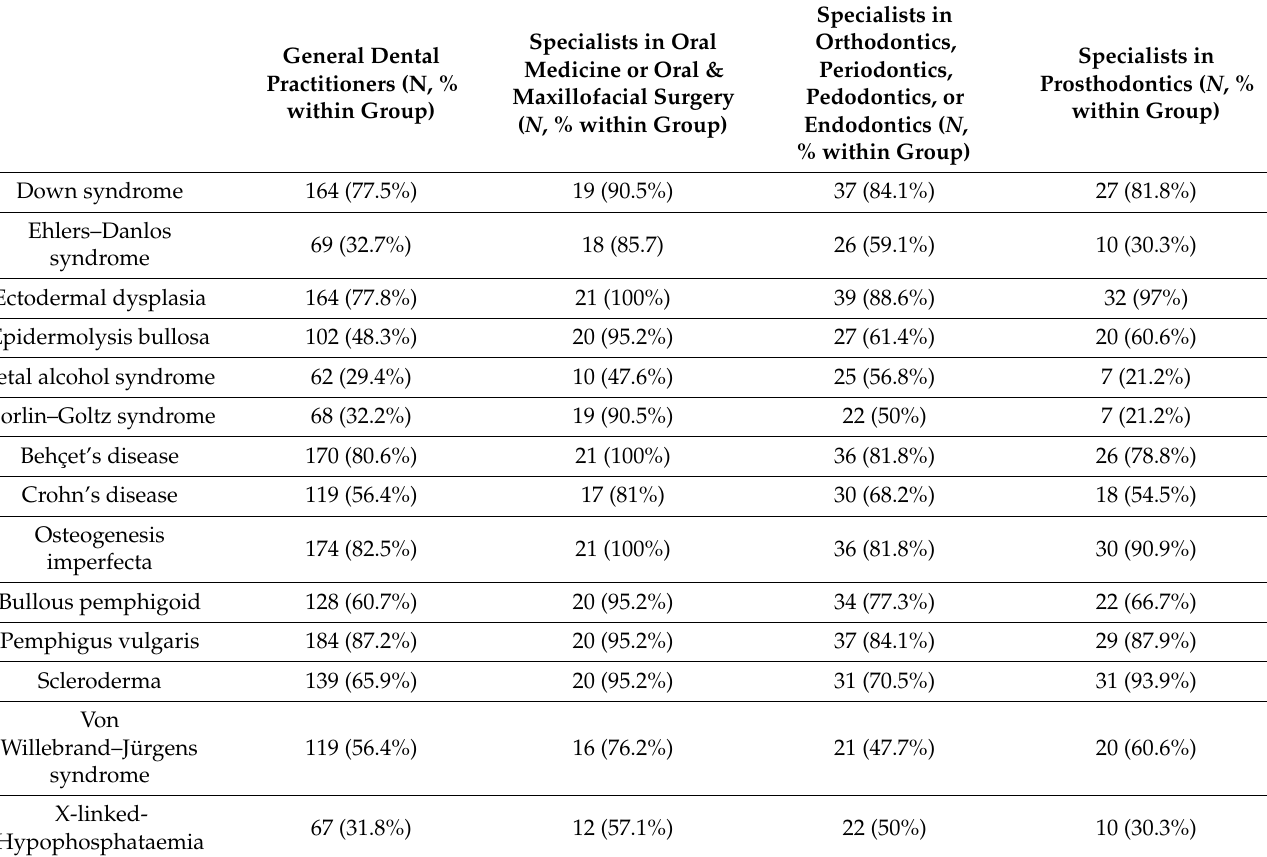
Table 6. Breakdown of recognition of the different 14 rare diseases with possible manifestation in the oromaxillofacial